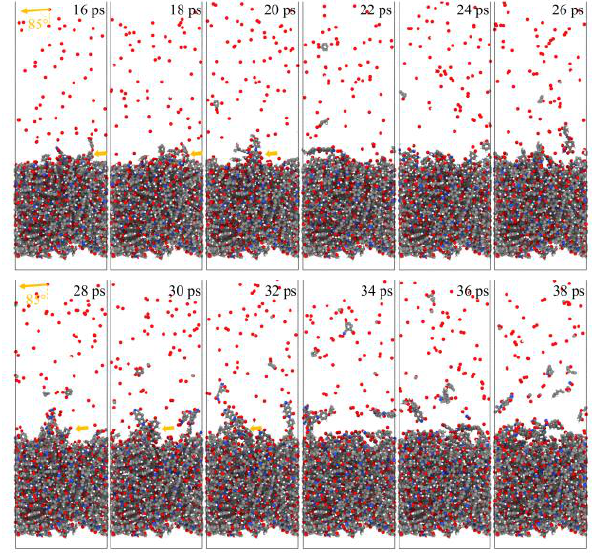
Figure 16. Evolution of the initial phase of atomic oxygen impacting Kapton material surface at 85° incidence angle.